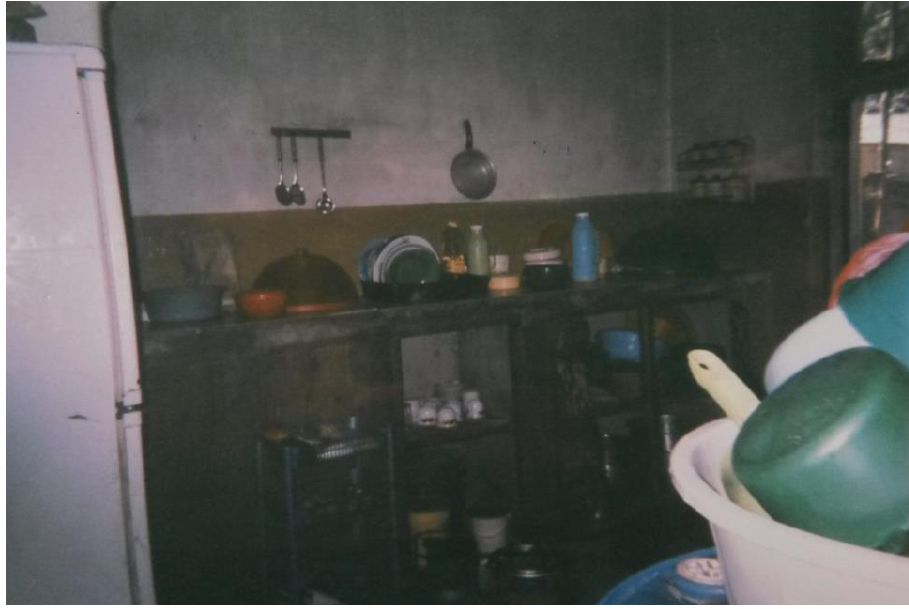
Figure 8. ‘We are supposed to live in a nice place [ mahala pazuri ] ’ . (Maimuna, 12 years